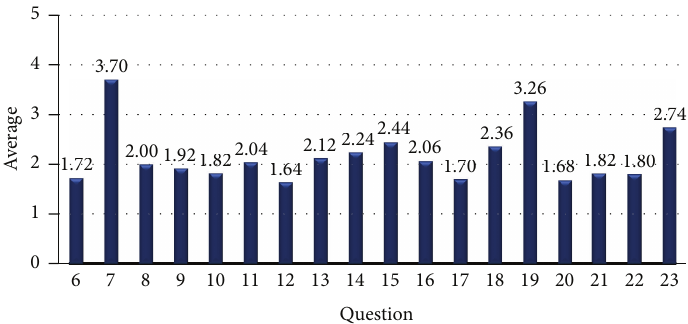
Figure 25: Summary of responses to student opinion survey (Section-B).